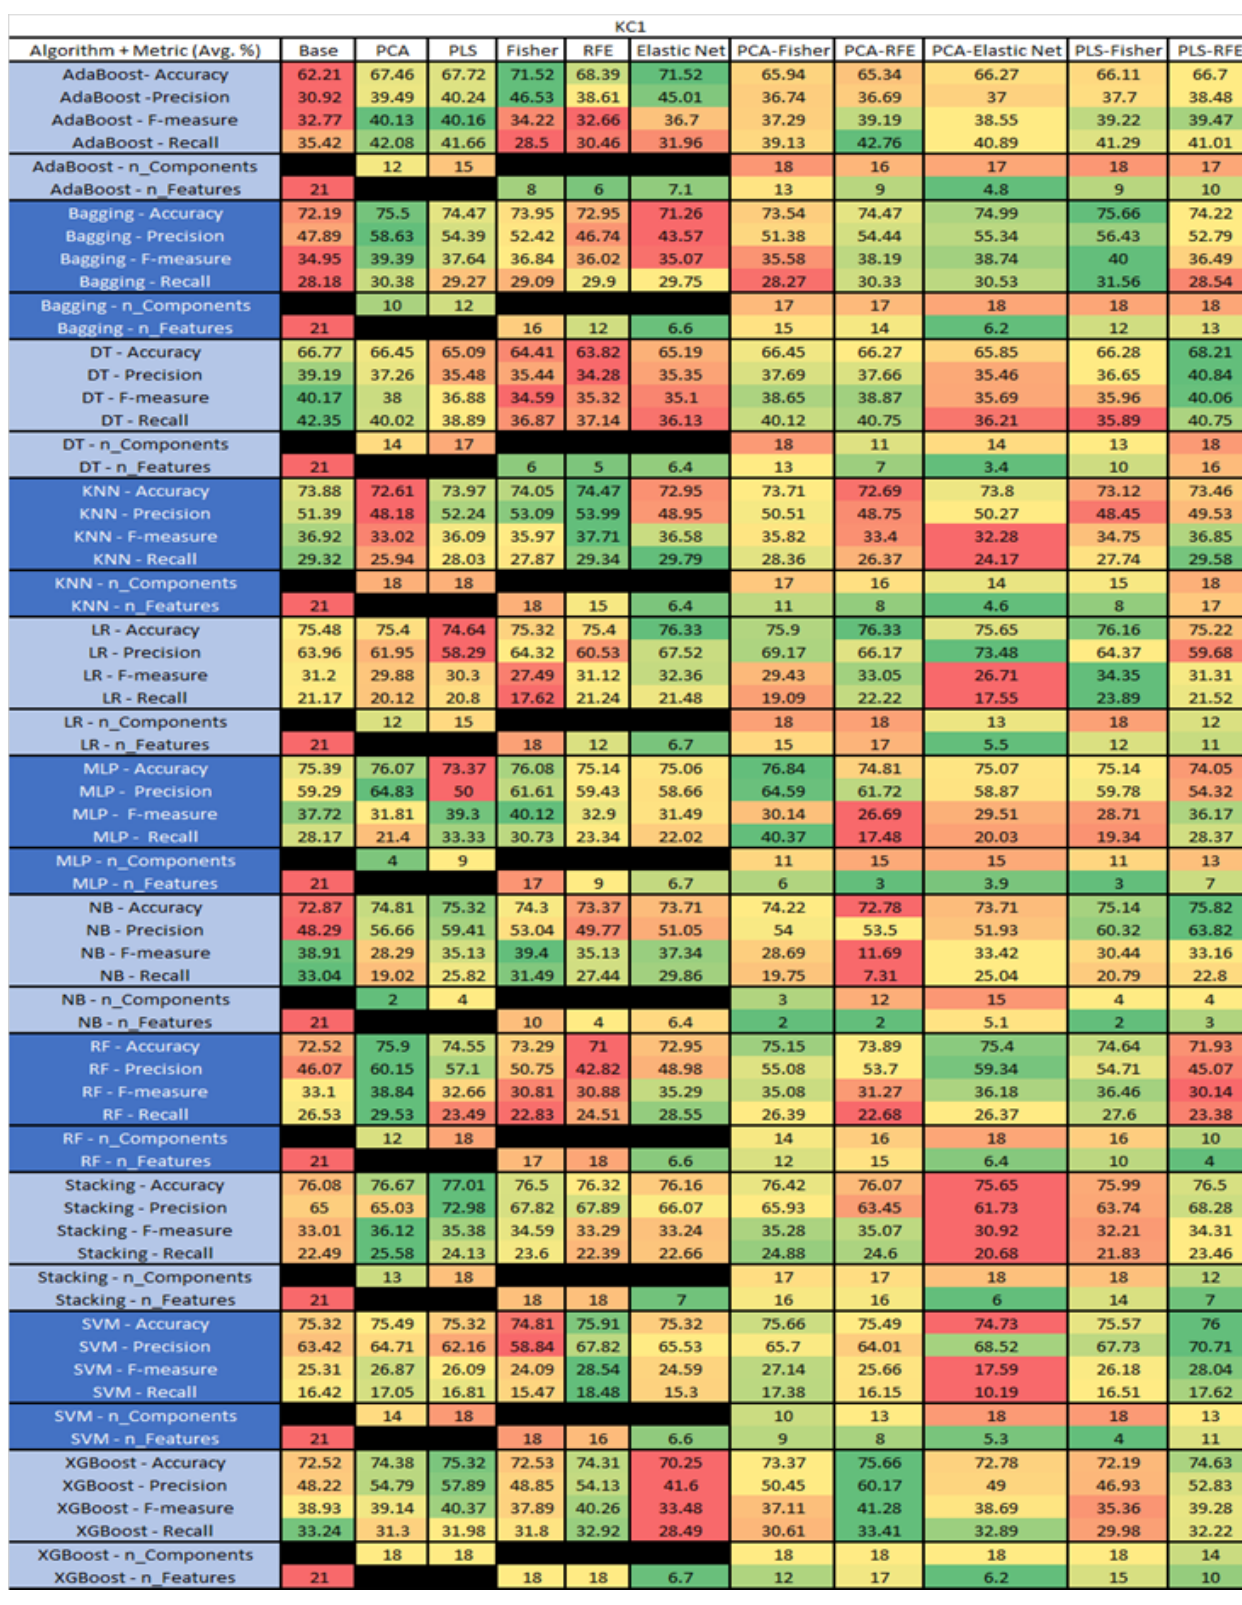
Figure 26. KC1 NASA MDP Results Data